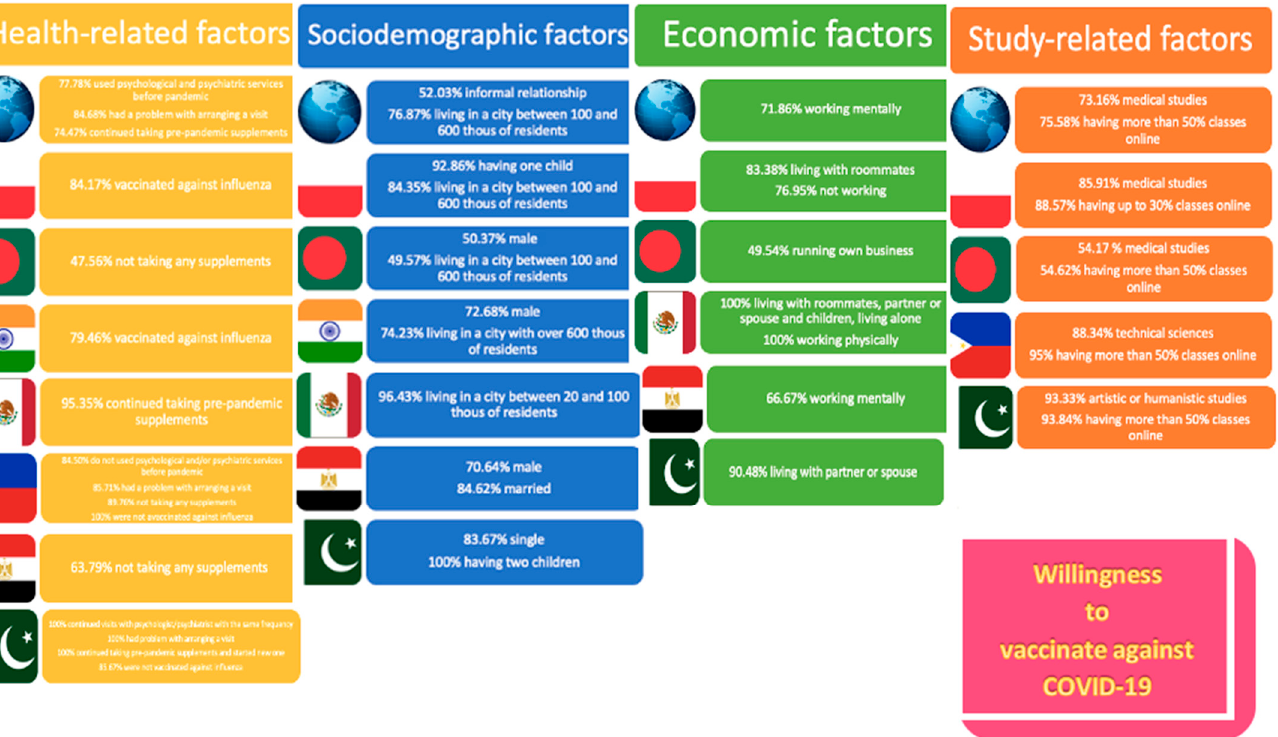
Figure 2. Percentage of students who expressed willingness to vaccinate against COVID-19 concerning only statistically significant results.